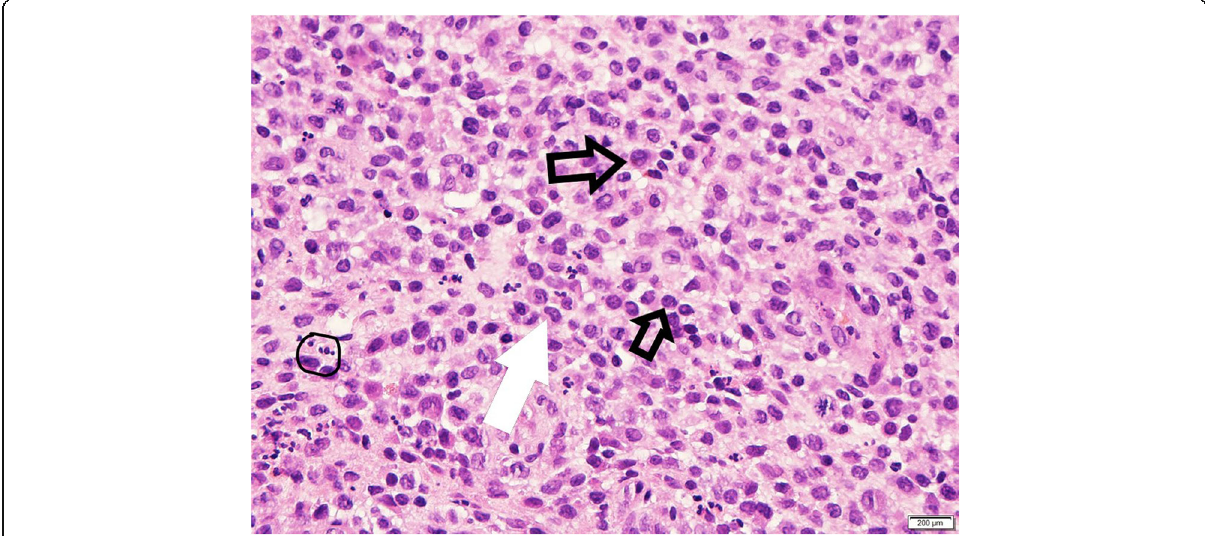
Fig. 1 Microscopic findings: Numerous dyscohesive sheets of neoplastic cells which are moderate in size displaying rather uniform grooved nuclei. (black arrows). Some of the cells show indented and kidney-bean shaped nuclei (white arrow). Mitotic figures are frequent and abnormal forms are present. Scattered mixed population of eosinophils, lymphocytes and some neutrophils (black circle) are also seen in the background. CD1 alpha and S100 are